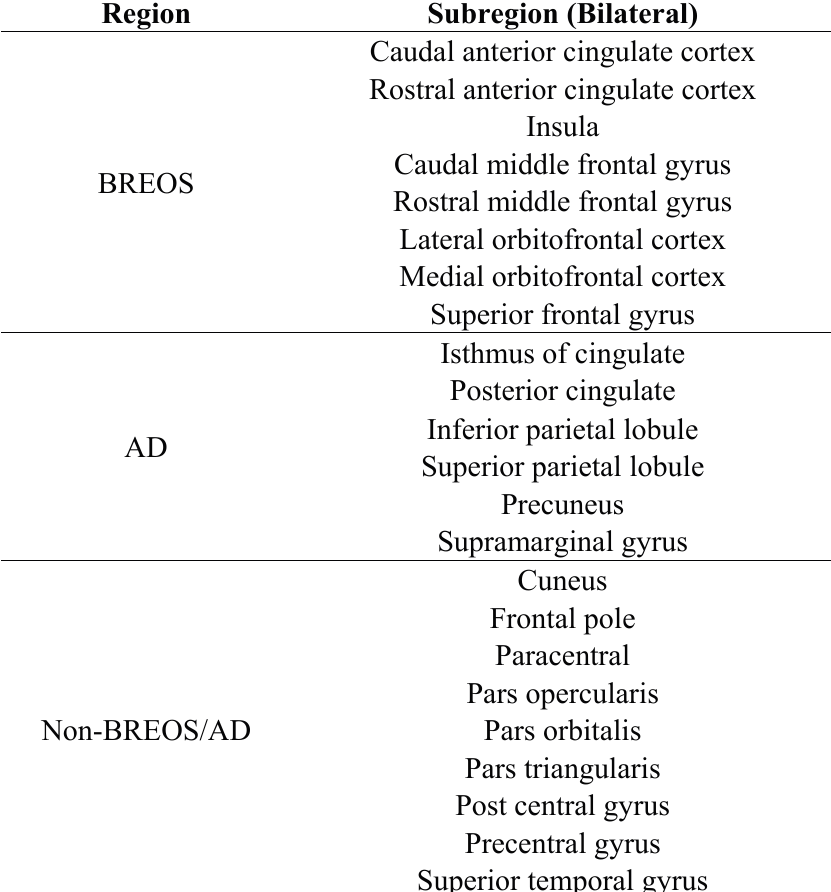
Table 2. Cortical regions of